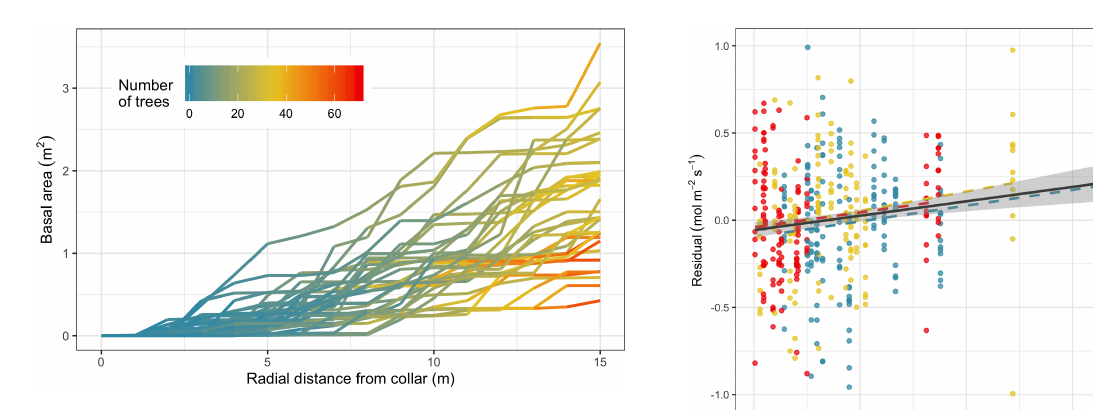
Figure 3. Cumulative basal area for each soil collar ( N = 36) up to 15m. Color indicates the number of trees at each distance, and each line is an individual collar. Figure 4. Residuals of a soil respiration model, incorporating tem- perature and soil moisture as independent variables, versus cumula- tive tree basal area within 5m, by site. Each point is an individual observation (see Fig. 2). Regression lines are shown for each site; the black line is the overall trend. Note that five extreme points are out of the plot but are accounted for in the regression